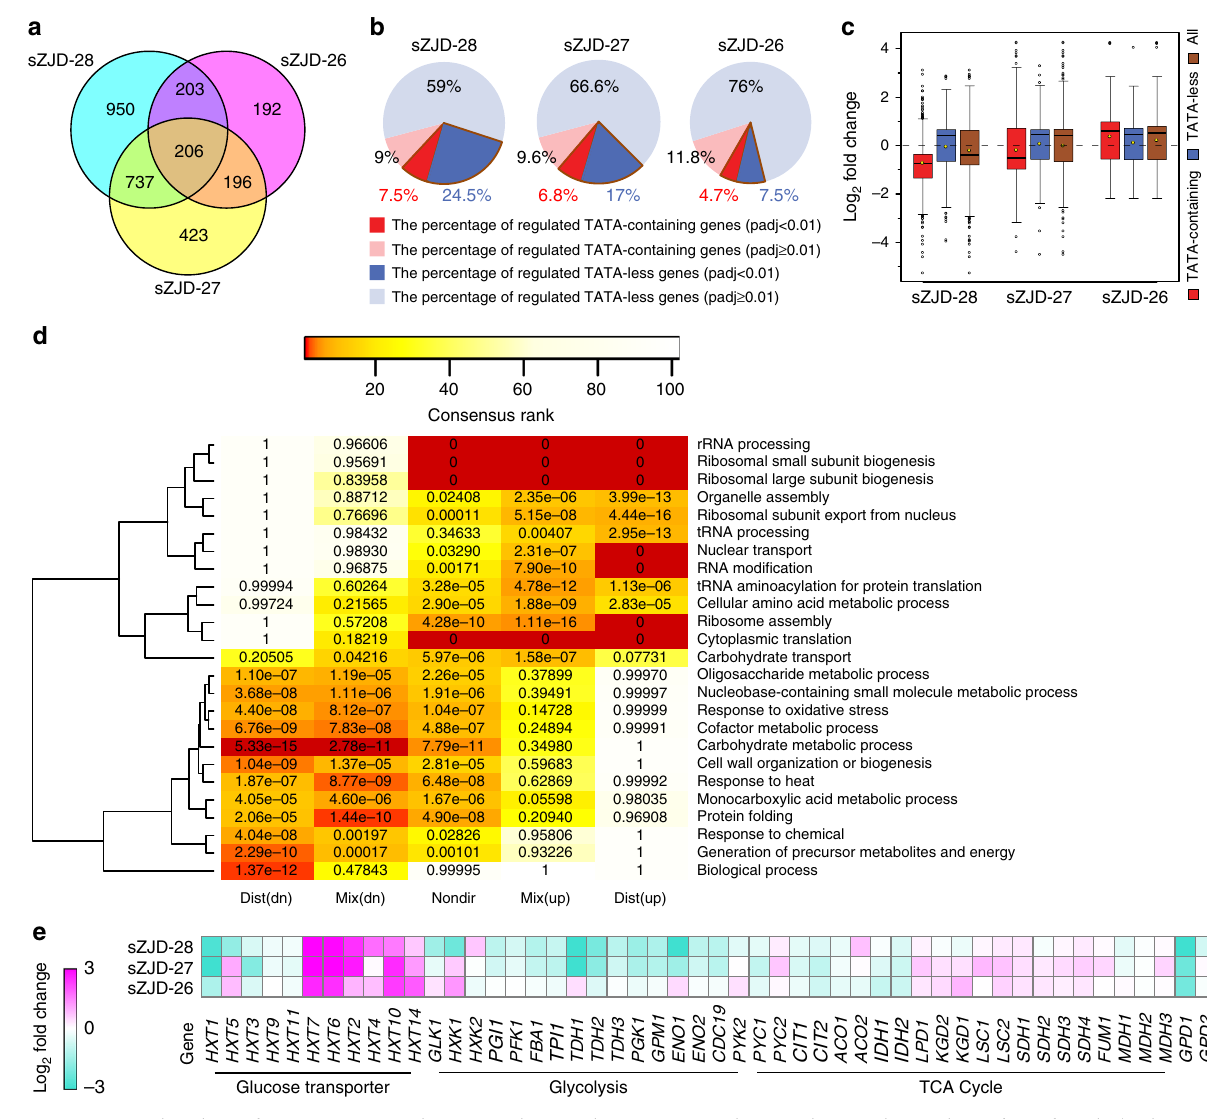
Figure 10). Expression of high-af fi nity glucose transporters were repressed by high levels of glucose and induced by low levels of glucose 22 . Transriptional changes in these glucose transporters indicated that glucose uptake was restricted in sZJD-28 compared with sZJD-25. Additonally, almost all of the genes in glycolysis were downregulated in sZJD-28 (Fig. 3e). Restricted glucose uptake and activity of glycolysis would release the burden on the respiration chain, which is consistent with the the expression pro fi les of oxidative phosphorylation (OXPHOS) genes, especially in sZJD-28 NADH dehydrogenase genes ( NDE1 and NDE2 ) and ubiquinol-cytochrome c oxidoreductase genes (complex III), which were signi fi cantly downregulated compared with sZJD-25 (Supplementary Figure 11). These results indicate that the limited NATURE COMMUNICATIONS| (2018) 9:3059 |DOI: